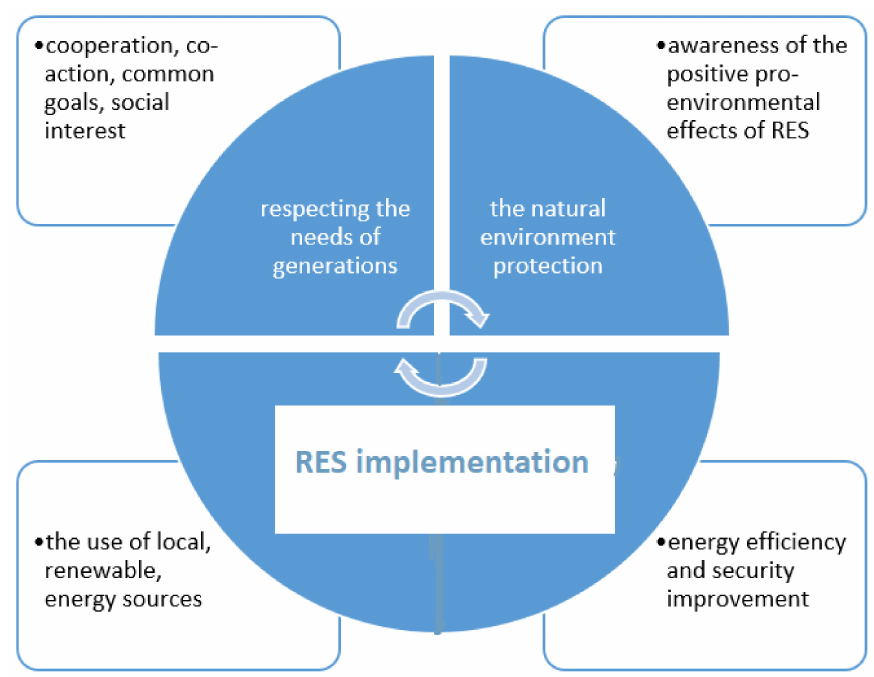
Figure 9. Homo energeticus as a new pattern behaviour in sustainable energy